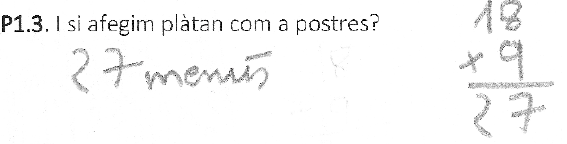
Figure 6. Correct answer of Q3. Decomposition strategy into sub-problems.